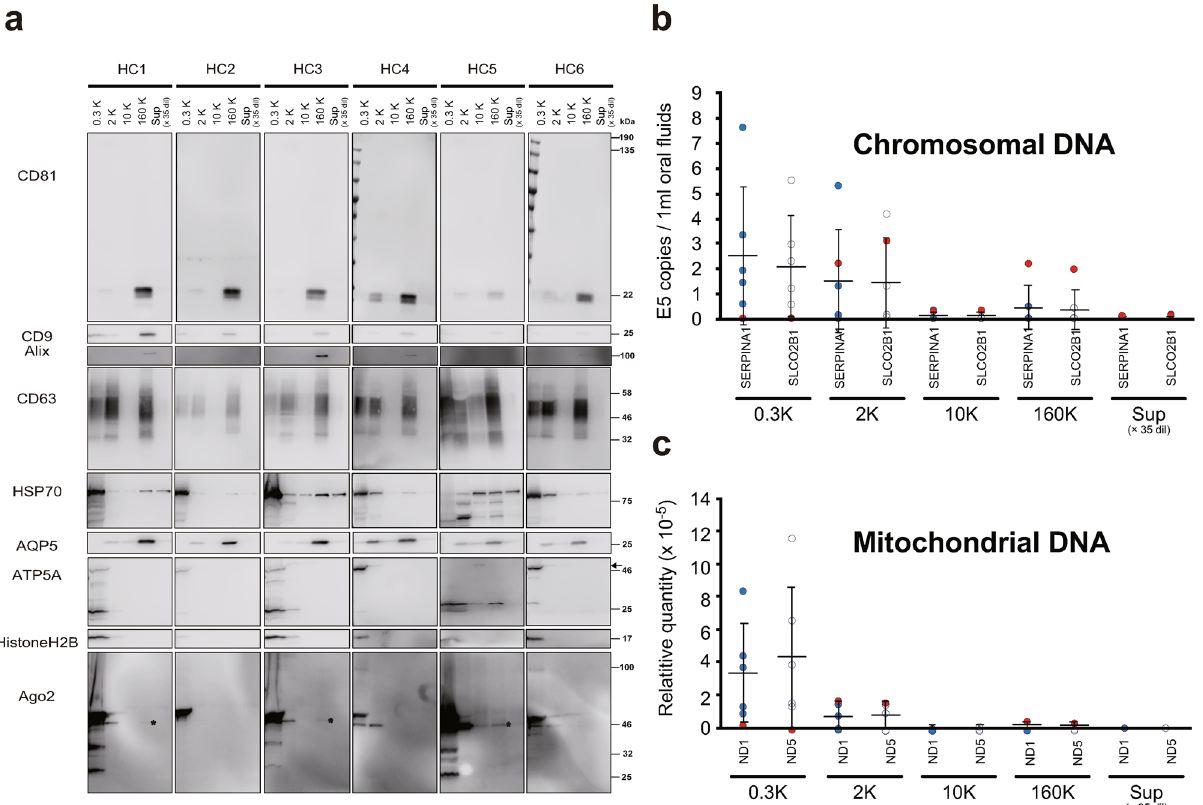
Figure 2. Distributions of protein markers, chromosomal DNA, and mitochondrial DNA in the pentapartite fractions of oral fluids (OFs) from 6 healthy volunteers. ( a ) Western blots of proteins markers for canonical exosomes (CD81, CD9, Alix, CD63 and HSP70), salivary gland (AQP5), mitochondria (ATP5A), chromatin (Histone H2B), and miRNA-associated protein (Ago2). Numbers on the right indicate molecular weight × 10 –3 . Black arrow shows the expected size of ATP5A. Asterisks in the 160K fractions of Ago2 are discussed in the text. Note that Sup was diluted 35-fold. The copy numbers of chromosomal DNA ( b ), and mitochondrial DNA ( c ), were determined by quantitative PCR. Target genes were SLCO2B1 and SERPINA1 for chromosomal DNA and ND1 and ND3 for mitochondrial DNA. The OFs were obtained from n = 6 healthy donors. Data are expressed as the mean ± standard deviation (SD). Dots indicate the mean value of the three measurements for each subject, while the mean values obtained from six subjects are represented as solid horizontal lines. Note that Sup was diluted 35-fold. The data obtained from HC45 are shown by red filled circles (see “Results”